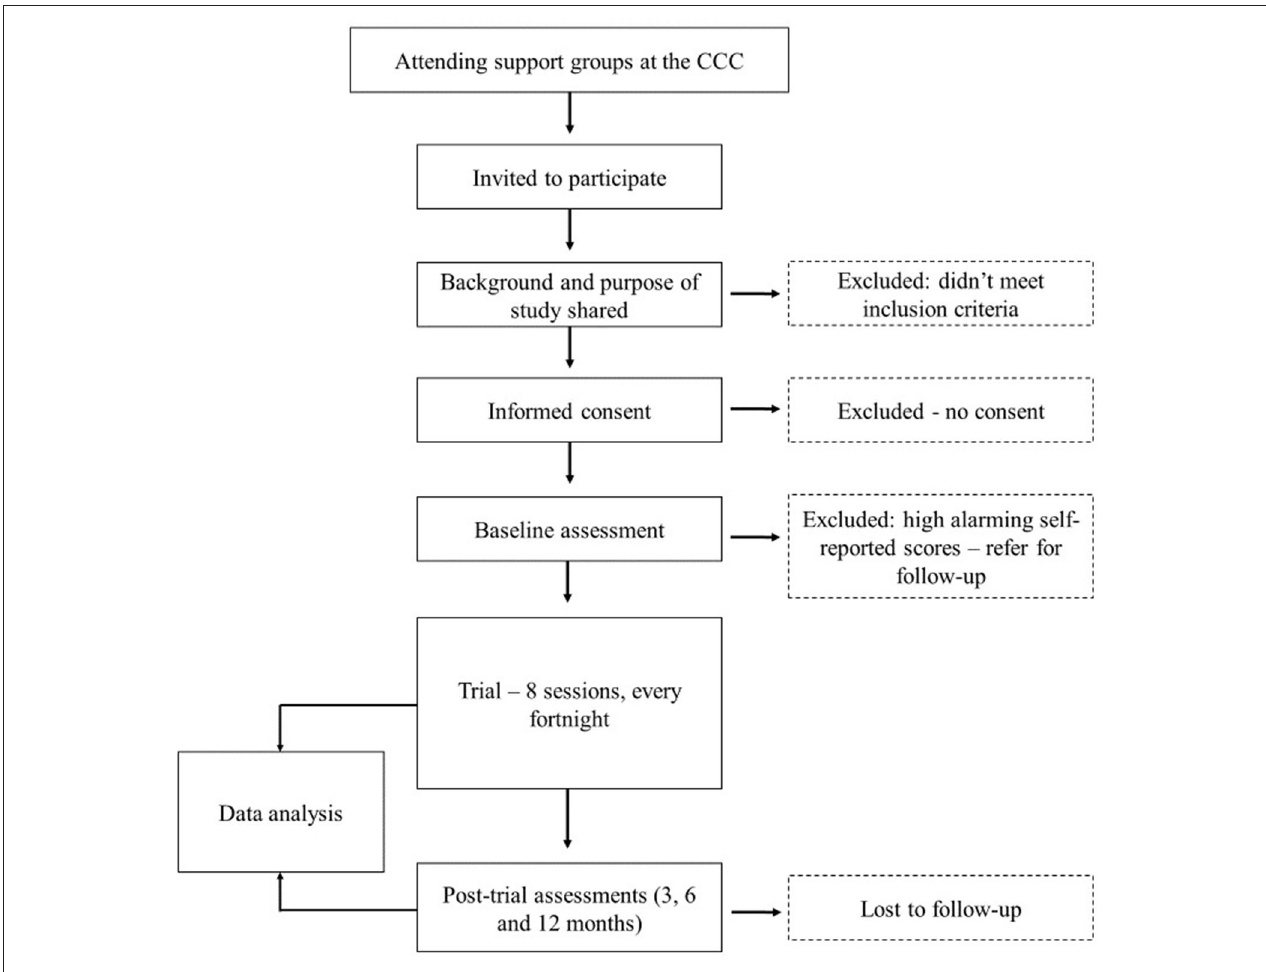
FIGURE 1 | Flowchart of participant recruitment and